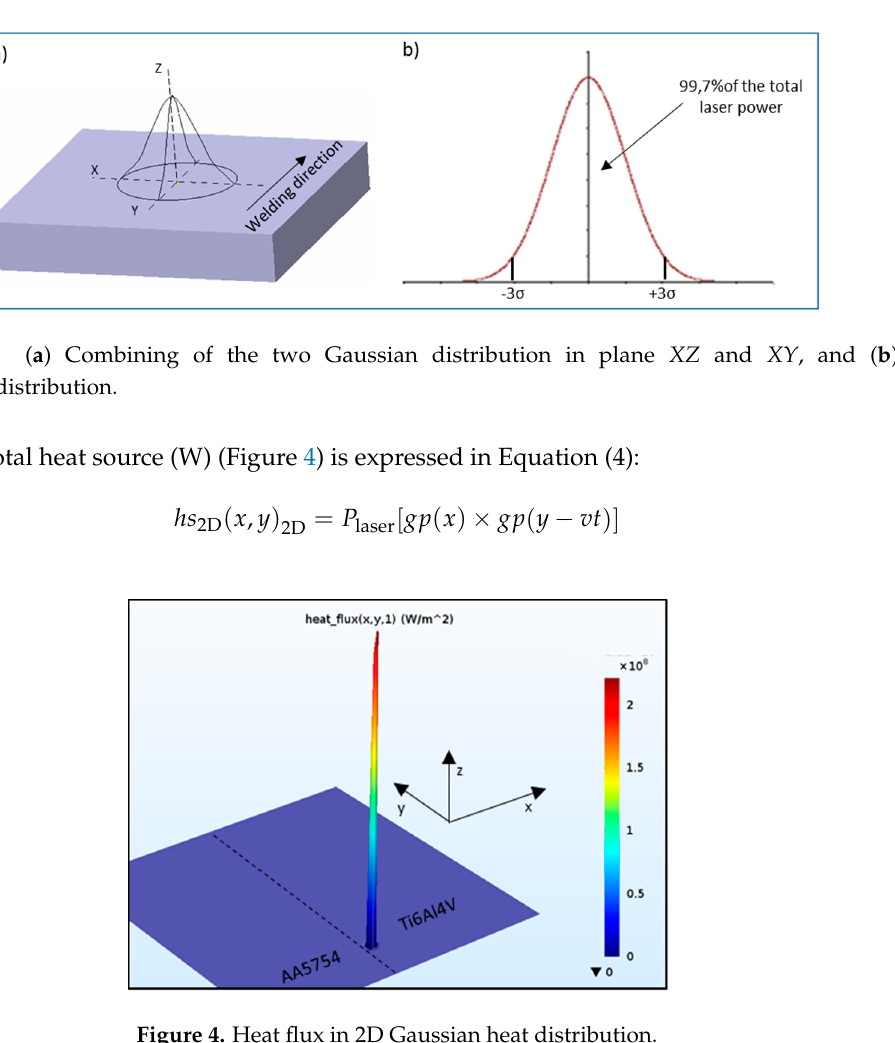
Figure 4. Heat flux in 2D Gaussian heat distribution.